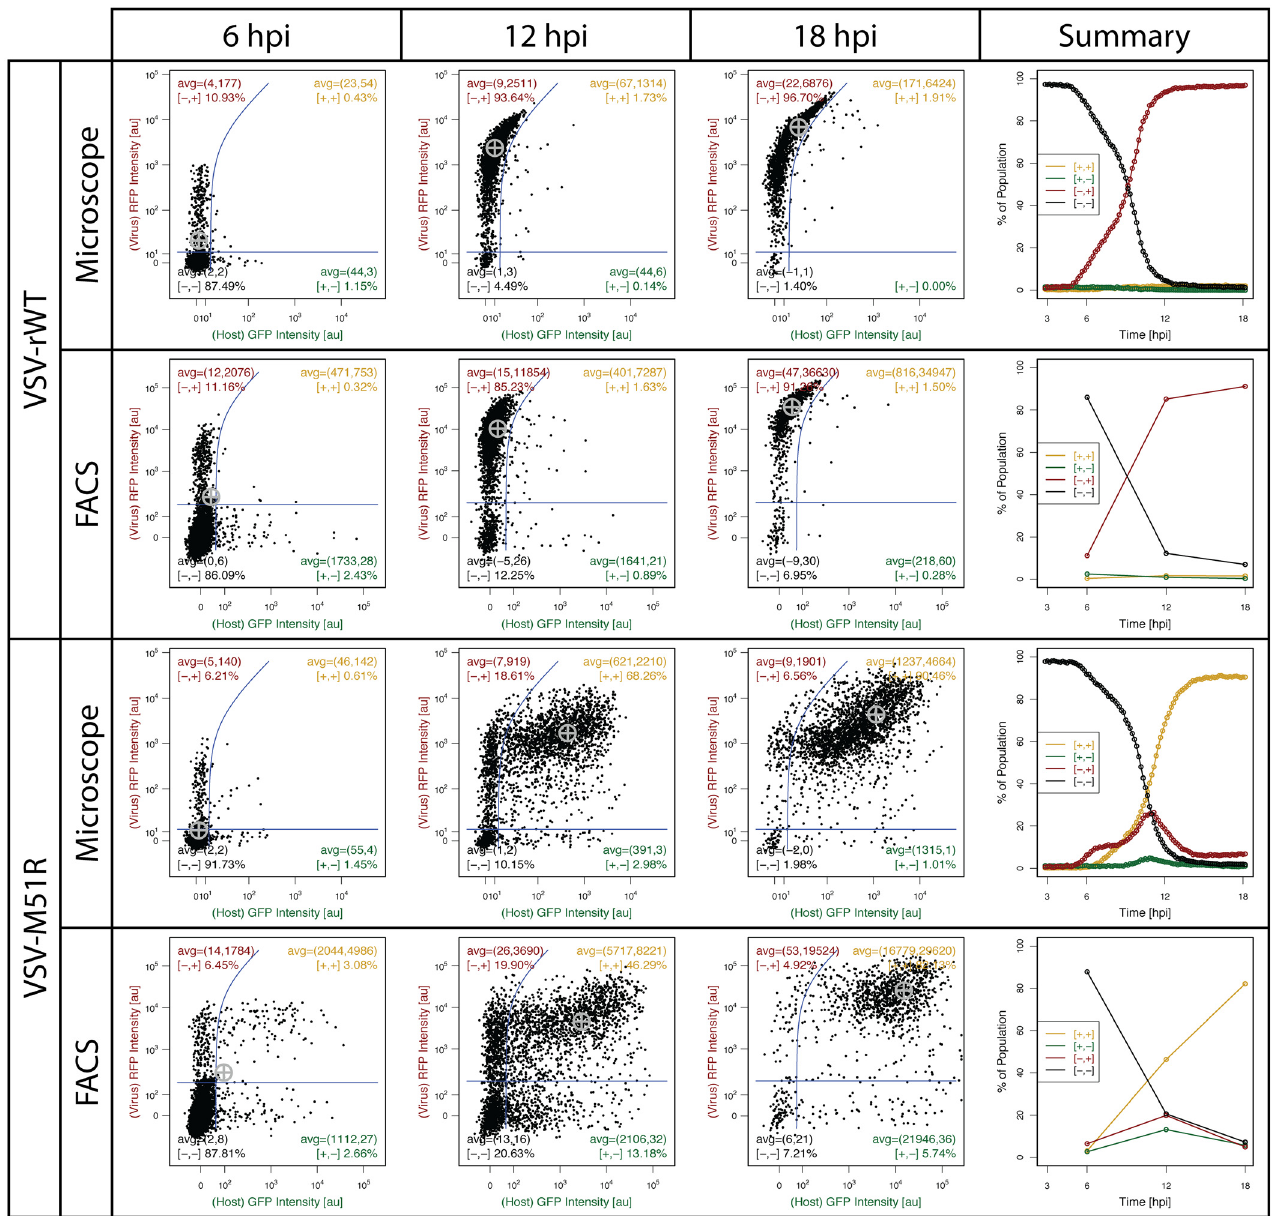
Fig 6. Movie frames of FC and microscopy PDC plots at 6, 12, and 18 hpi. The green and red fluorescence of each cell in VSV-rWT and VSV-M51R infections are shown in each scatter plot. All timepoints for the microscopy data are taken from the same sample whereas the FC data at each timepoint represents data from separate samples obtained in parallel. Furthermore, the microscope sample was sacrificed at 18 hpi and used for the FC 18 hpi timepoint. Thus, the 18 hpi timepoint is the same sample for both methods and is directly comparable. The summary plots on the right-hand side show gated population percentages over time, illustrating the similarity in sensitivity of the two methods but highlighting the improved temporal resolution of the microscopy approach. The gray cross-hair in each plot represents the overall population mean. movie version of the PDC plots contained in the S1 Text illustrate the kinetic heterogeneity of virus-host interactions. It appears that in most cells the viral reporter rises first, while in a minority of cells the host response reporter can be readily detected before the viral reporter. In this way, cells appear to take different ‘ trajectories ’ through the plot of red vs green, passing